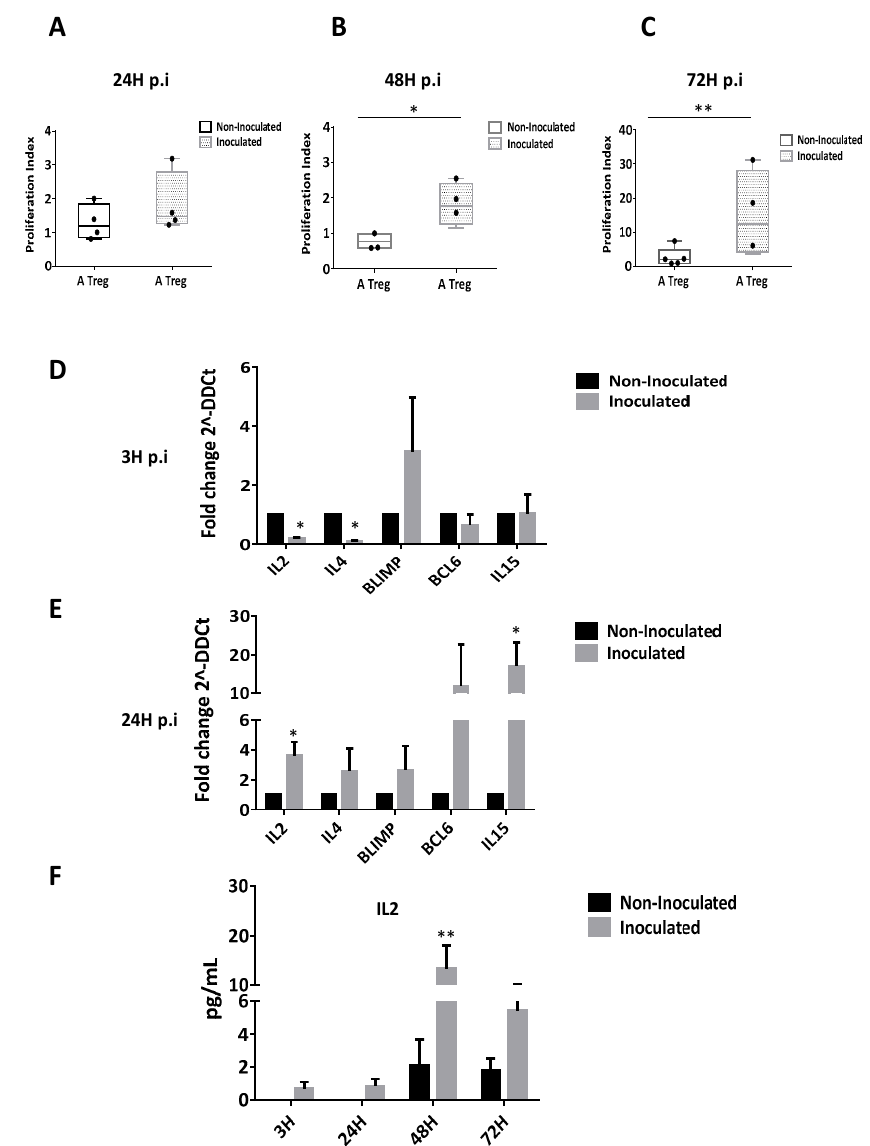
Figure 4. HCV inoculation increases the in vitro proliferative capacity of Tregs. Tregs proliferation was measured by using [ 3 H]-thymidine incorporation assay and cell counting assays at 24 h ( A ), 48 h ( B ) and 72 h ( C ) after HCV inoculation. Results are expressed in index of proliferation of inoculated Tregs (hatched column) compared to non-inoculated (light column). Results are presented as mean values of triplicate ± SEM bars of four independent experiments. qPCR analyses showed that HCV inoculation increases IL-2, IL-4, BLIMP1, BCL6 and IL-15 gene expressions in Tregs at 3 h p.i, ( D ) and 24 h p.i ( E ). Results are presented as means of four independent experiments in inoculated Tregs (light grey bars) versus non-inoculated Tregs (dark bars). Gene expressions are normalized by using GADPH, beta-actin, 18s and HRPT mRNA as housekeeping-genes and the results are expressed in fold change (2 – ∆∆ Ct ) ± SEM bars. Secretion of the proliferative cytokine IL-2 by Tregs after HCV inoculation ( F ). Results are expressed as mean of three independent experiments and presented in pg / mL ± SEM bars comparing secretion by inoculated Tregs (light grey bars) versus non-inoculated Tregs (dark bars). p ≤ 0.05 (*), p ≤ 0.001